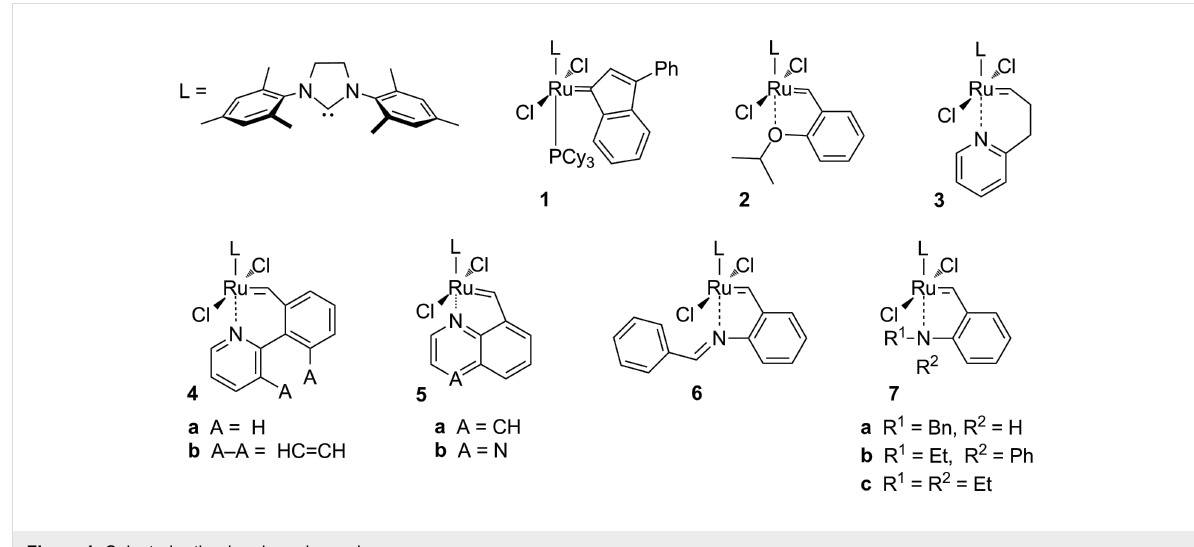
Figure 1: Selected ruthenium-based